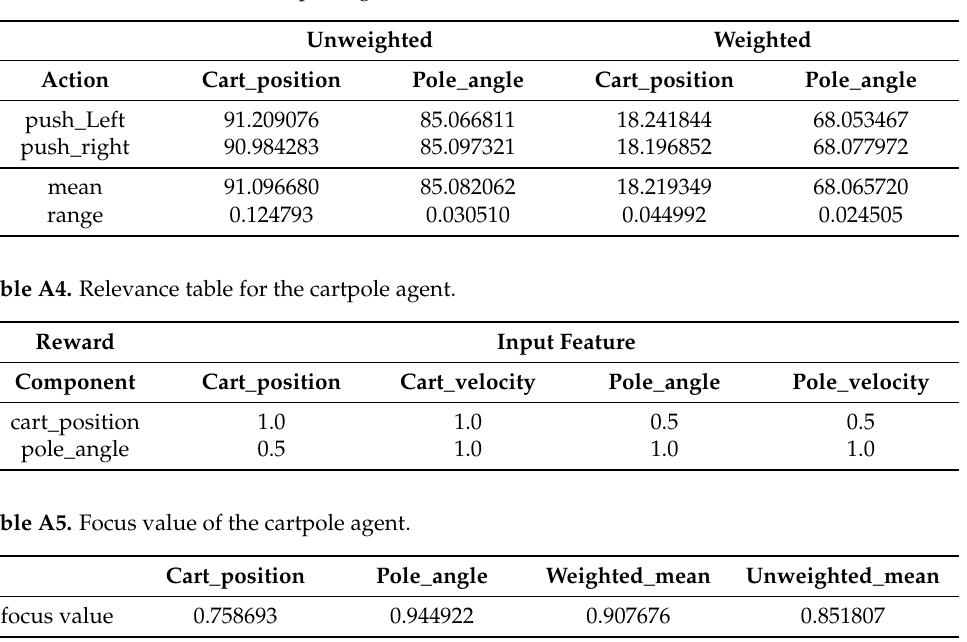
Table A3. Base values of the cartpole agent.